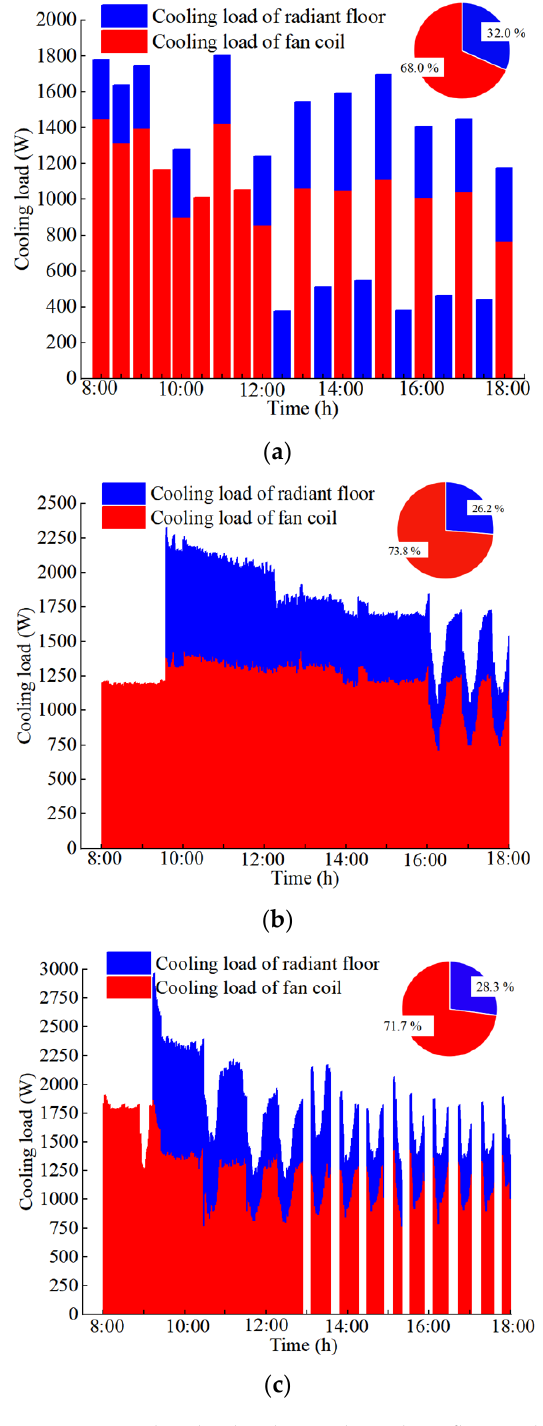
Figure 14. Cooling loads taken on by radiant floor and fan coil under the ( a ) LH, ( b ) HL, and ( c ) MM operating strategies.